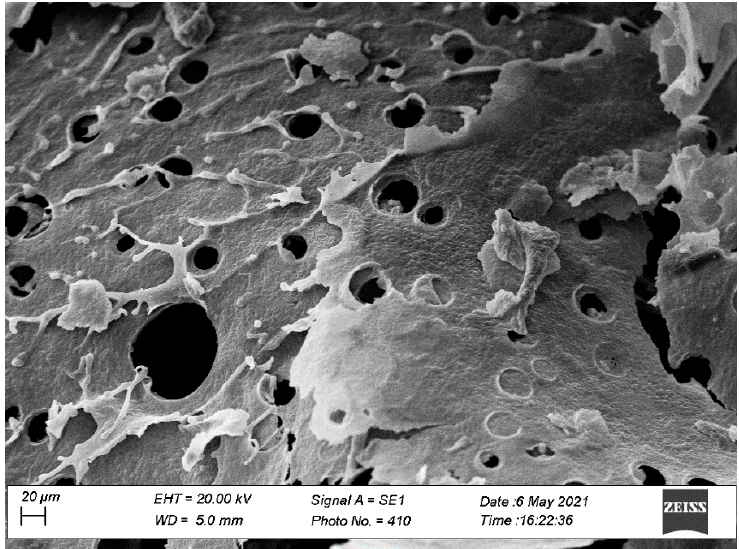
Figure 4. BioQ-CPX surface morphology evaluated by SEM analysis; magnitude bar: 20 µm.